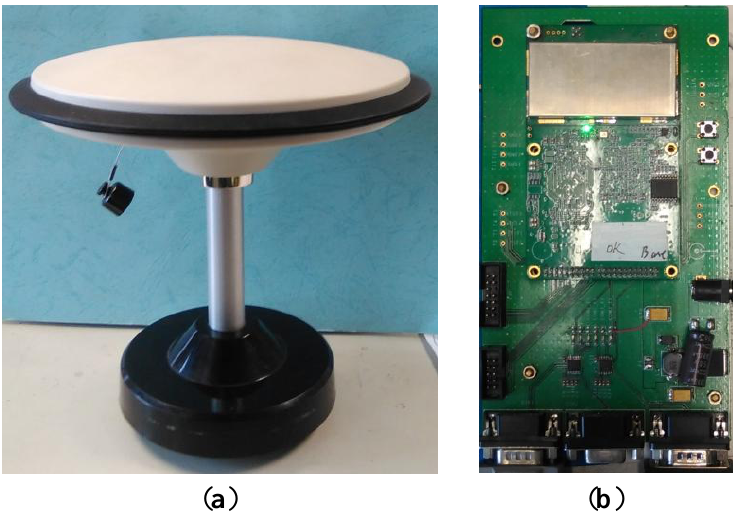
Figure 2. Experiment devices ( a ) antenna ( b ) receiver circuit